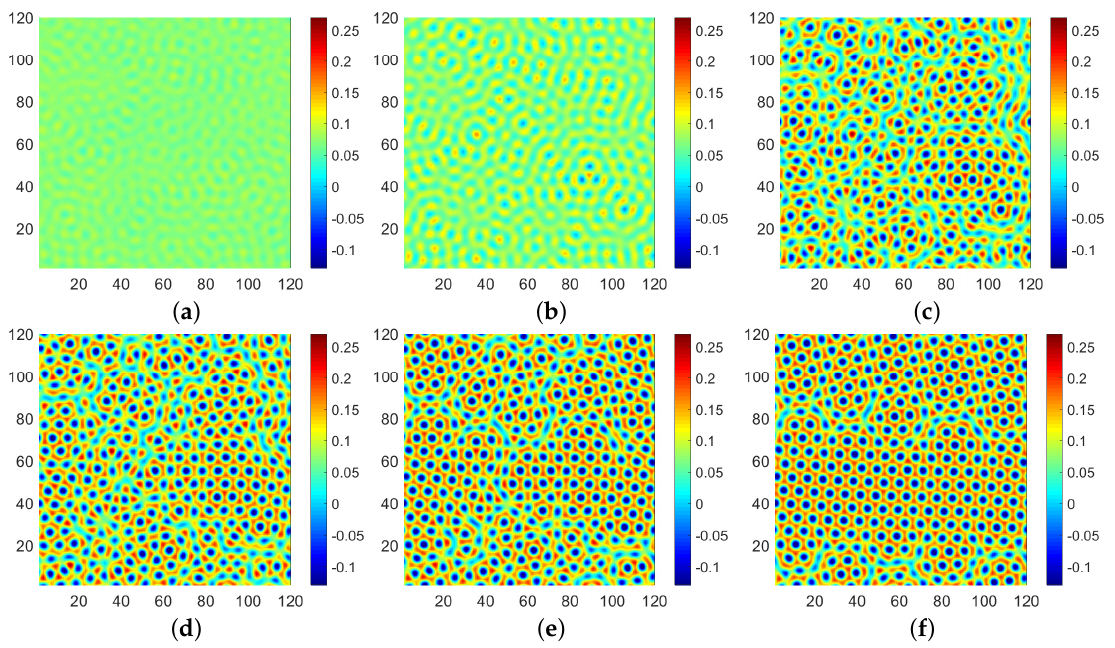
Figure 17. ( a – f ) are the snapshots of numerical solutions of the classical phase-field crystal (PFC) model with the initial condition (50) at t = 30,000 ∆ t , 210,000 ∆ t , 450,000 ∆ t , 600,000 ∆ t , 900,000 ∆ t , and 1,500,000 ∆ t , respectively. For colored figures, see the manuscript of web version.